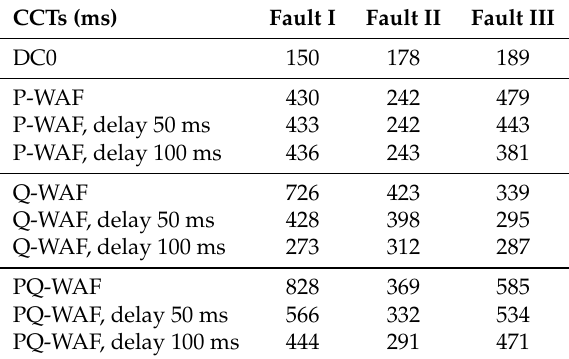
Table 3. Case A. CCT. Effect of communication